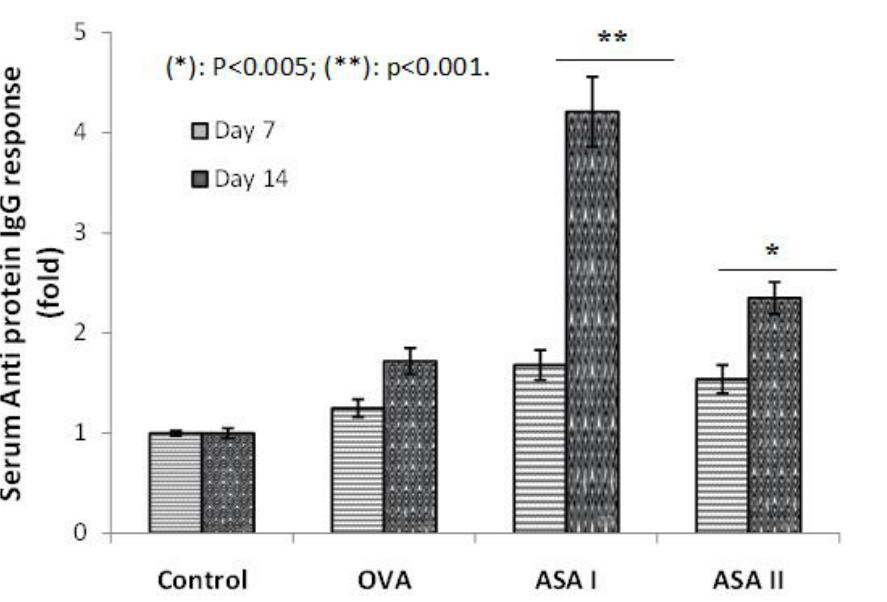
Figure 3. Serum IgG systemic immune response to ovalbumin (OVA) and garlic lectins (ASA I and II) after intradermal administration in BALB/c mice. Antigens (100 µ L/well) were coated overnight, washed, blocked with BSA, and incubated with test serum. Detection with goat anti-mouse IgG-AP and PNPP substrate. The IgG response is represented as a fold increase in comparison with control, taking the absorbance of the control as 1. Panel indicates IgG immune response against OVA, ASA I, or ASA II as assessed by ELISA using the serum of experiment animals obtained at day 7 and day 14 by the intradermal route. Coated antigen amount: 10 μ g/well; IgG serum dilution, 1:10 (volume: 100 μ L); * p < 0.005; ** p < 0.001.